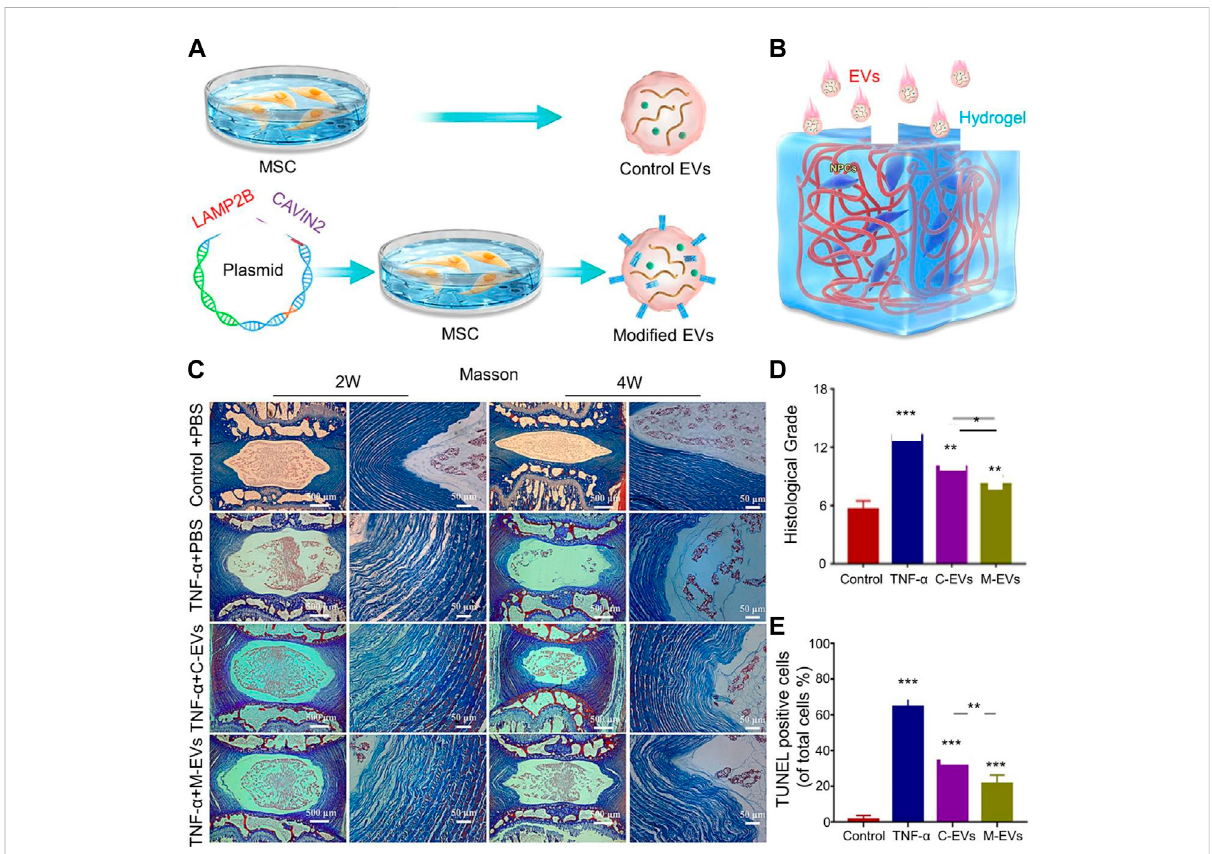
FIGURE 1 (A) Schematic diagram of the extracellular vesicle (EV) engineering process modi fi ed by Cavin-2. (B) Schematic illustration of EV treatment of intervertebral discdegeneration(IVDD) inan in vitro alginate hydrogel model. (C) Masson staining histological analysis at2and 4 weeksoftreatment shows the morphology of IVDs in different treatment groups. (D) Histological grade based on the scale of disc degeneration in different groups. (E) Terminal deoxynucleotidyl transferase (TdT) dUTP Nick-End Labeling (TUNEL) staining shows the apoptosis of different groups. Reproduced with permission from (Liao et al.,